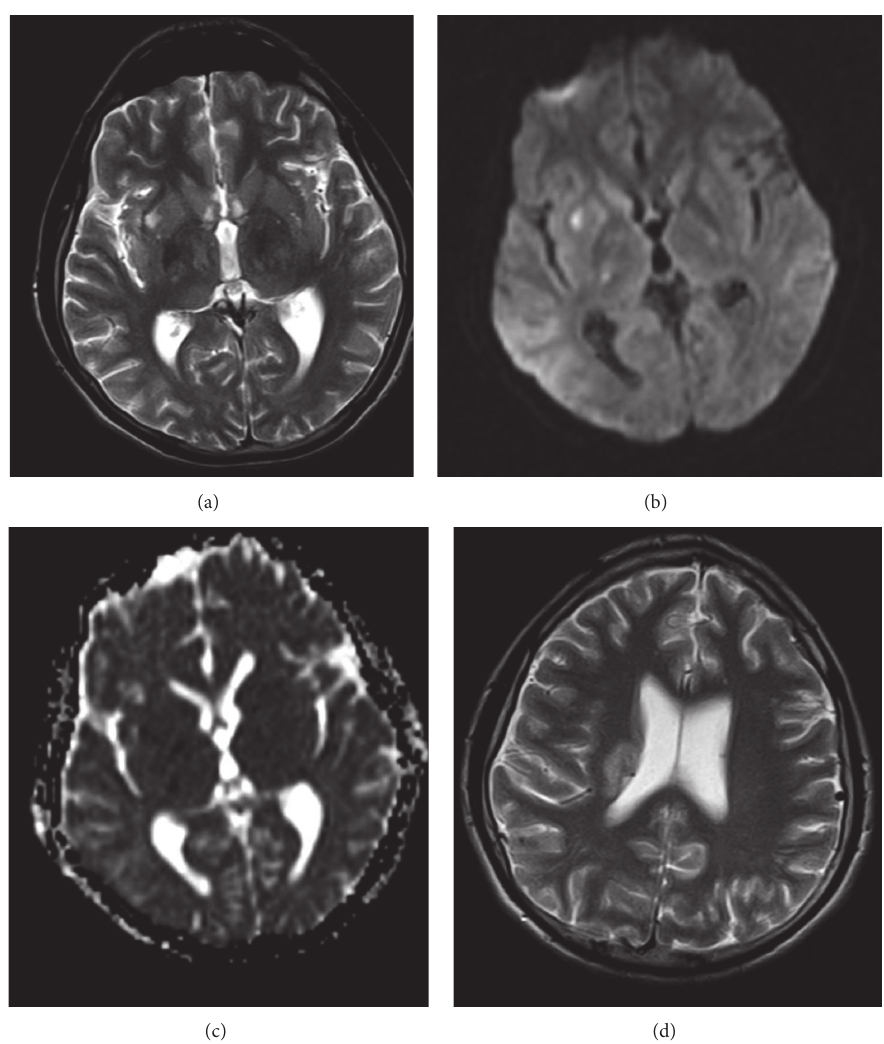
Figure 1: Instant diagnosis T2A (a), diffusion image (b = 1000s/mm 2 ) (b), ADC (c) map, and T2A image 15 days after diagnosis (d). Acute ischemic lesions in the right thalamus, globus pallidus, and lateral putamen (b, c), increases of bilateral hypothalamic T2 intensity (a), and corona radiata intensity increment after 15 days (d). After IVKM there was no inclusion of a parenchymal